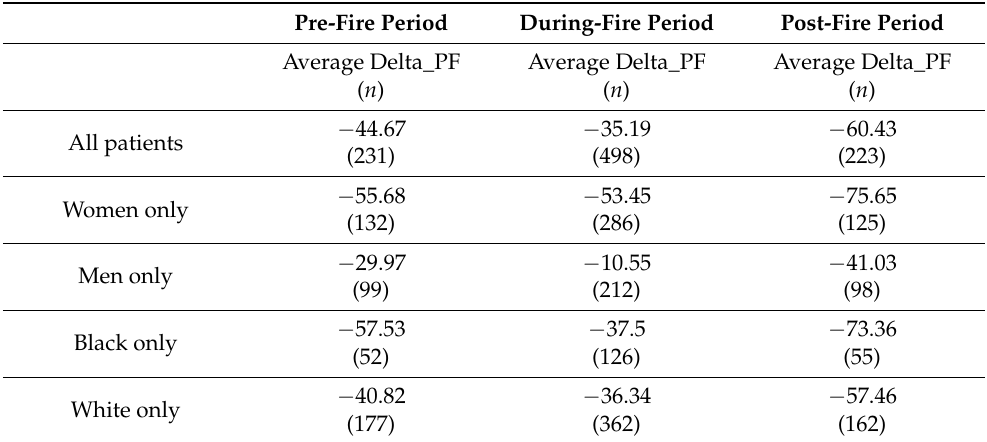
The repeated measures ANOVA with pairwise comparisons in Table 3 also suggested that delta_PF values were the most negative in the post-fire period relative to the during-fire and pre-fire periods. Data gathered from both Fire #1 and Fire #2 on patients who had clinic measured peak flow values across all three time periods (pre-, during, and post-fire) indicated that pairwise comparisons of the difference between the clinically measured peak flow vs. the predicted peak flow (delta_PF) were significantly different in the post-fire period when compared to the pre-fire or during-fire periods for Fire #1 and marginally significant for the during-fire vs. post-fire periods for Fire #2 (Table 3). The same pattern was observed for the clinically measured peak flow vs. their personal best (delta_best) outcome variable. Table 3. Repeated measures ANOVA with Tukey pairwise comparisons of the delta_PF value (clinic measured vs. predicted) for patients with peak flow measures recorded during the pre-fire, during- fire, and post-fire time periods. The analysis was performed separately for each fire. p -Value for Comparisons of Least Squares Mean Delta_PF by Time Delta_PF (Liters per Minute) Periods Fire #1 ( n = 378) Pre-fire − 35.00 During fire − 23.84 Post-Fire − 63.79 Pre-fire vs. During fire 0.11 Pre-fire vs. Post-fire <0.001 During fire vs. Post-fire <0.001 Fire #2 ( n = 162) Pre-fire − 45.42 During fire Pre-fire vs. During fire 0.40 Pre-fire vs. Post-fire 0.32 During fire vs.